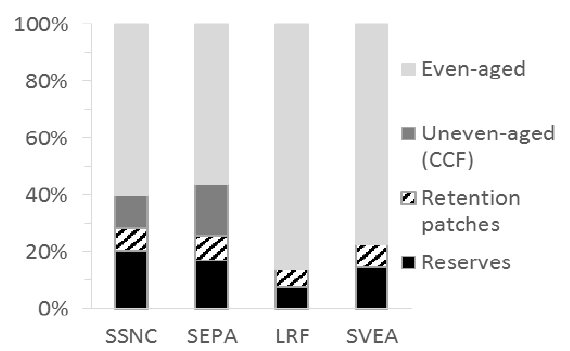
Figure 3. Proportion of forest area under different management regimes in the four stakeholder scenarios. Forest area in reserves (i.e., nature reserves and key habitats) is left unmanaged.